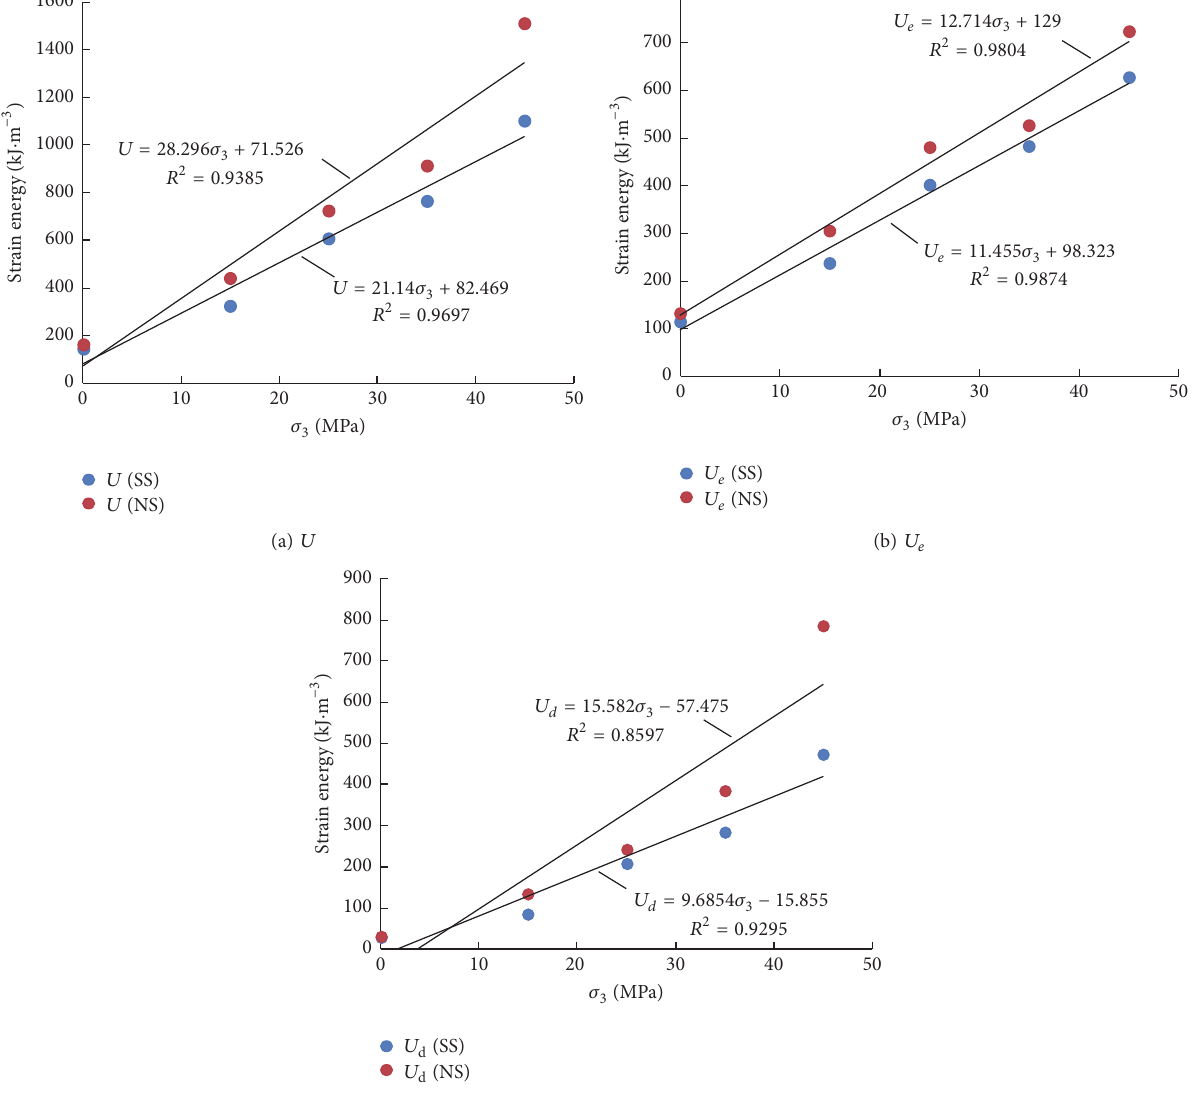
which leads to varying performance of rock